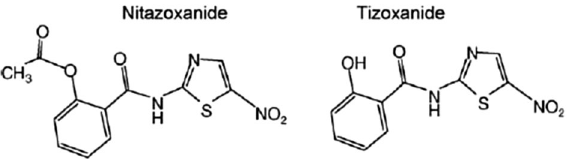
Figure 1. Chemical structure of nitazoxanide and tizoxanide (Korba et al. 18 ).